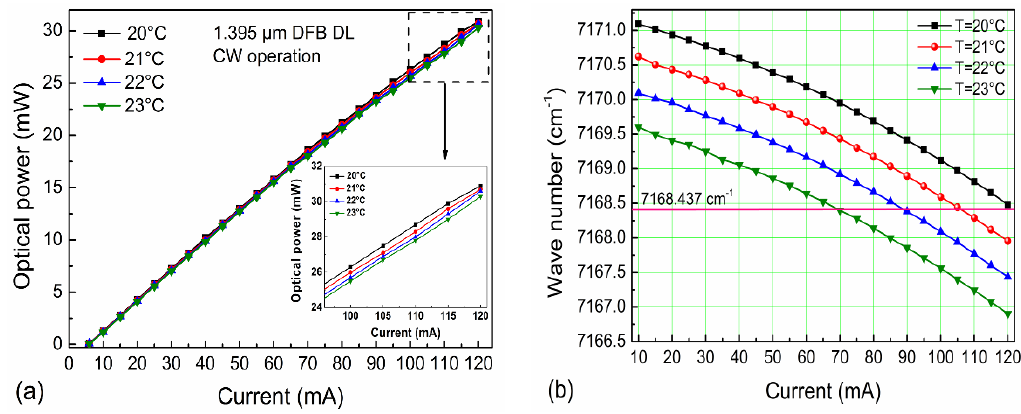
Figure 3. Diode laser output performance at four different temperatures: ( a ) optical power as a function of current; ( b ) diode laser current tuning plots.